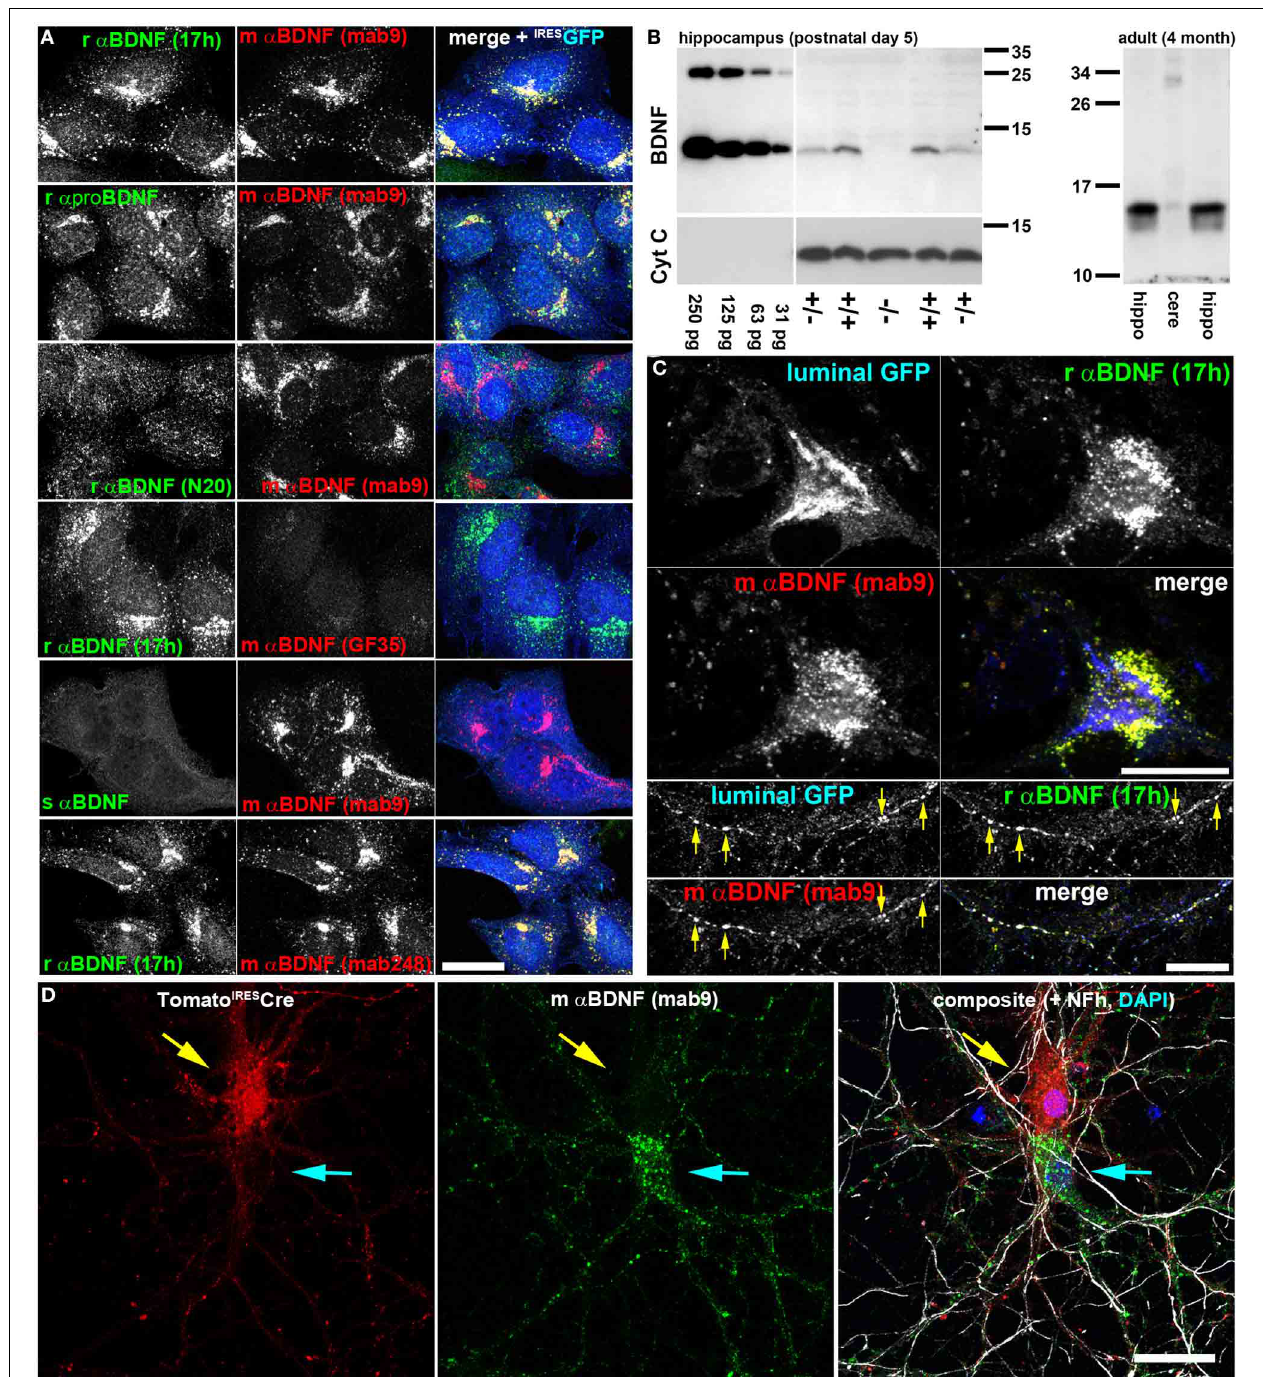
FIGURE 1 | Two anti-BDNF antibodies enable specific and dense indirect immunolabeling of endogenous BDNF in hippocampal neurons in vitro . (A) Antibody verification with recombinant BDNF. HeLa cells stably expressing lentivirally-delivered BDNF IRES GFP were labeled with different anti ( α )-BDNF antibodies from different species (r, rabbit; m, mouse; s, sheep). Antibody details are given in the Material and Method section. As transduction control, GFP was expressed bicistronically under an IRES2 sequence and postlabeled with chicken anti-GFP. BDNF was accumulated in